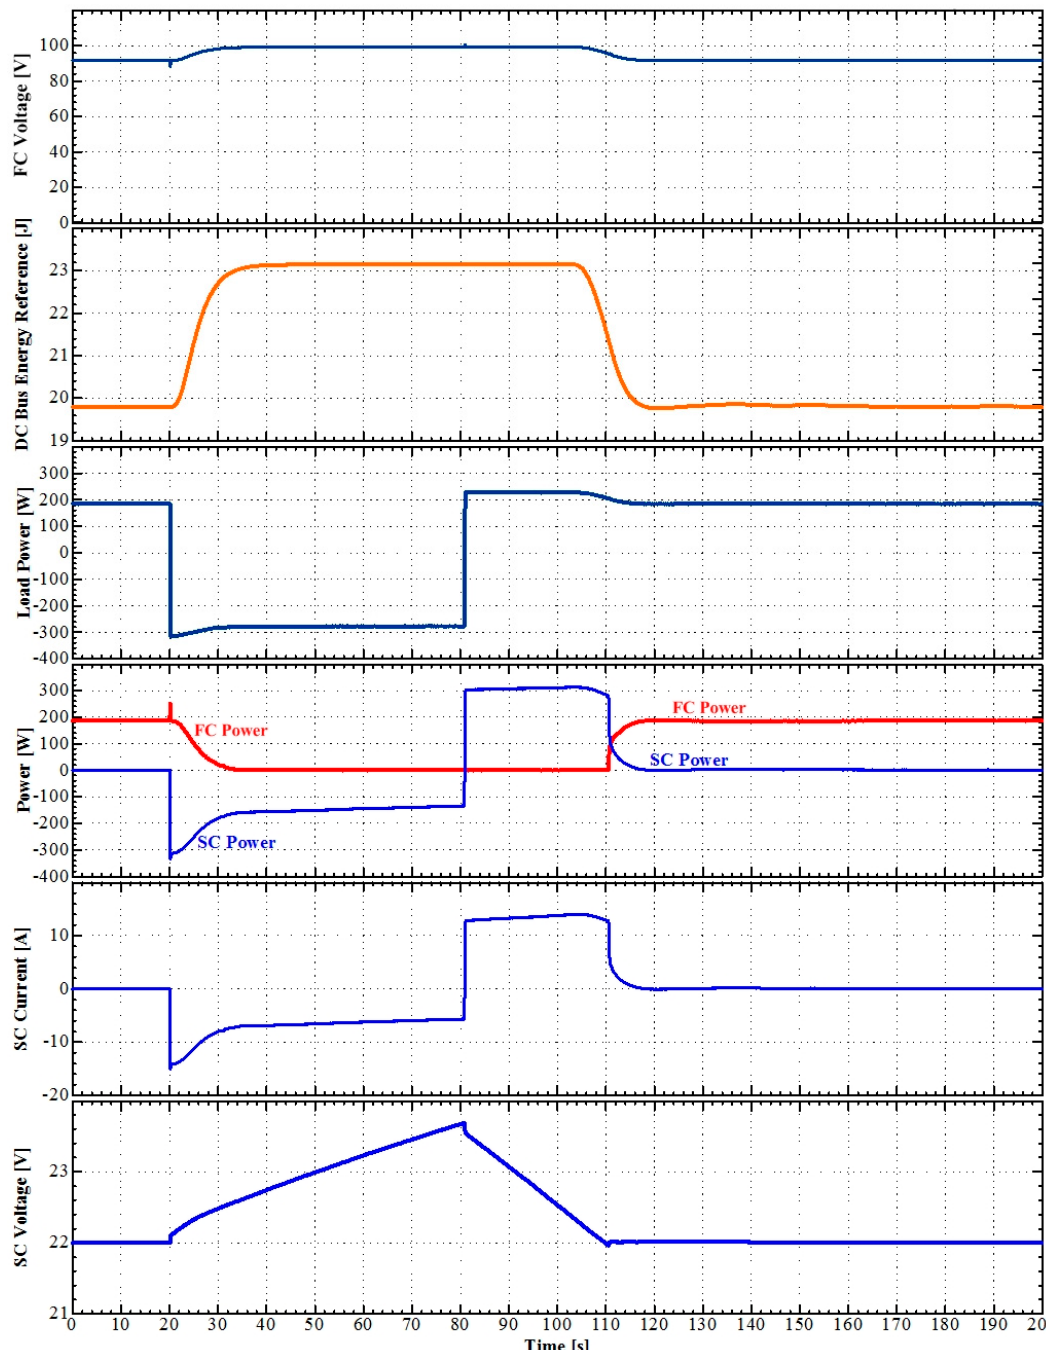
Figure 17. Obtained experimental results in motoring and ride-through modes.